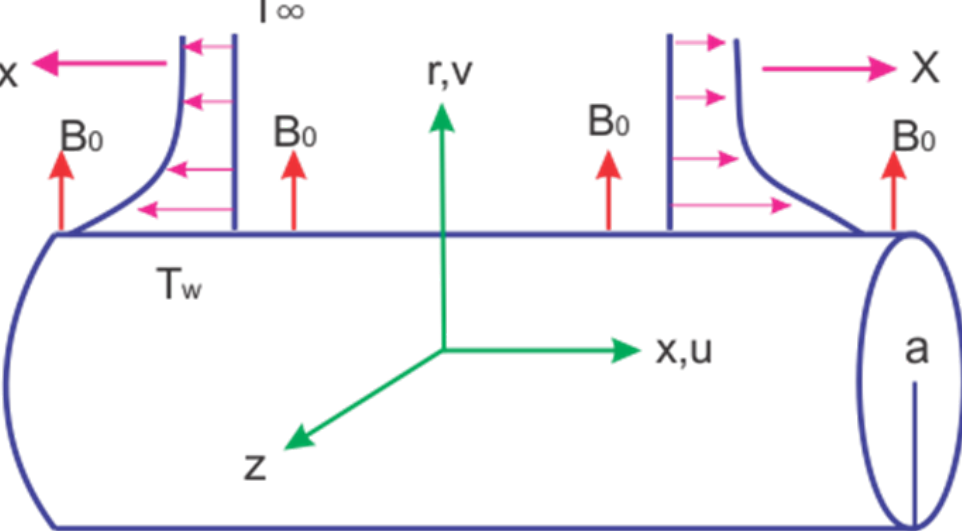
Figure 1. Physical sketch of flow phenomena.